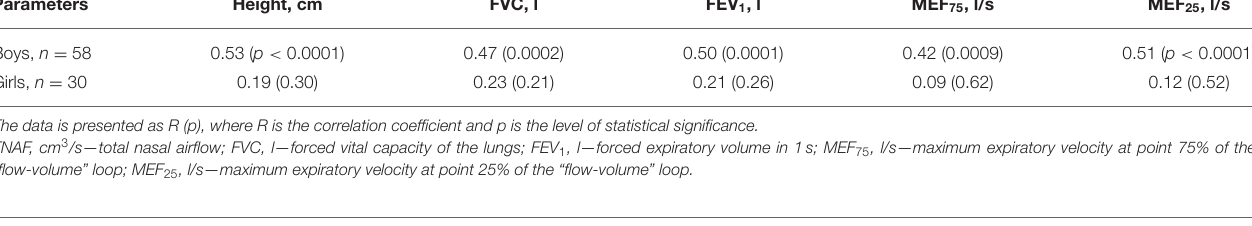
TABLE 5 | Relationship of relative indicators of total nasal airflow (RTNAF, %pred) to relative parameters of spirometry in children with BA, taking into account the gender of patients. FVC (%pred) FEV1 (%pred) FEV1/FVC